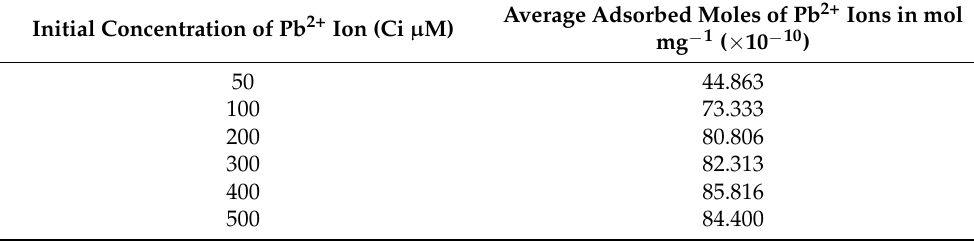
Table 1. Average adsorbed moles of Pb 2+ on the oxidized graphite (100 mg) with initial concentration of Pb 2+ in the range between 50 µM and 500 µM.